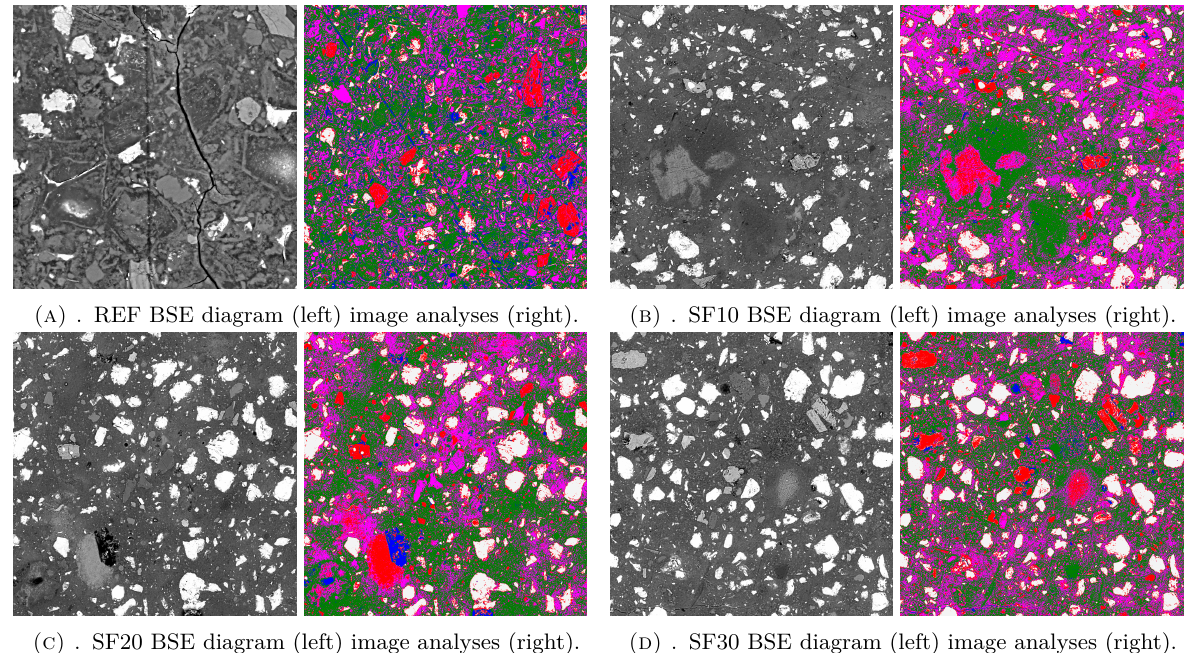
(a) . REF BSE diagram (left) image analyses (right). (b) . SF10 BSE diagram (left) image analyses (right).